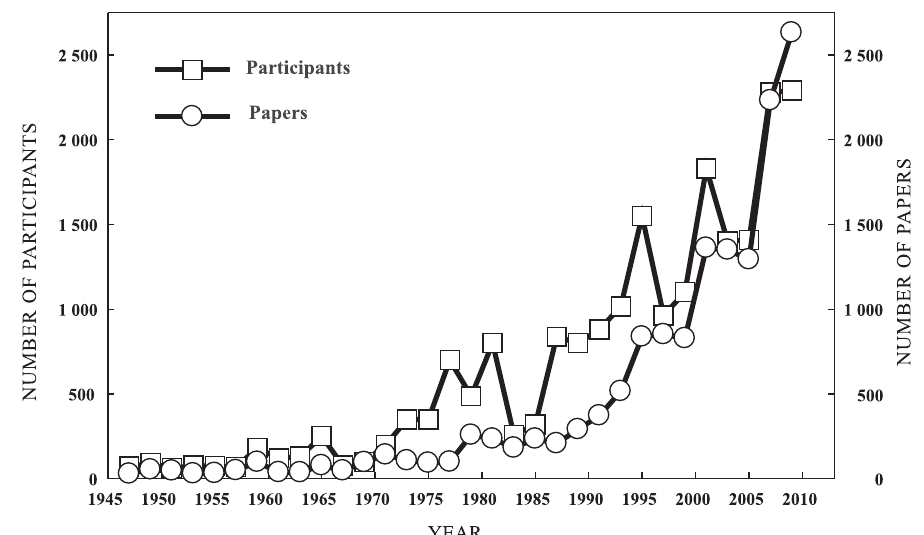
Figure 2. Number of participants and papers in 32 editions of the Brazilian Congress of Soil Science promoted by the SBCS in Brazil (Oliveira,